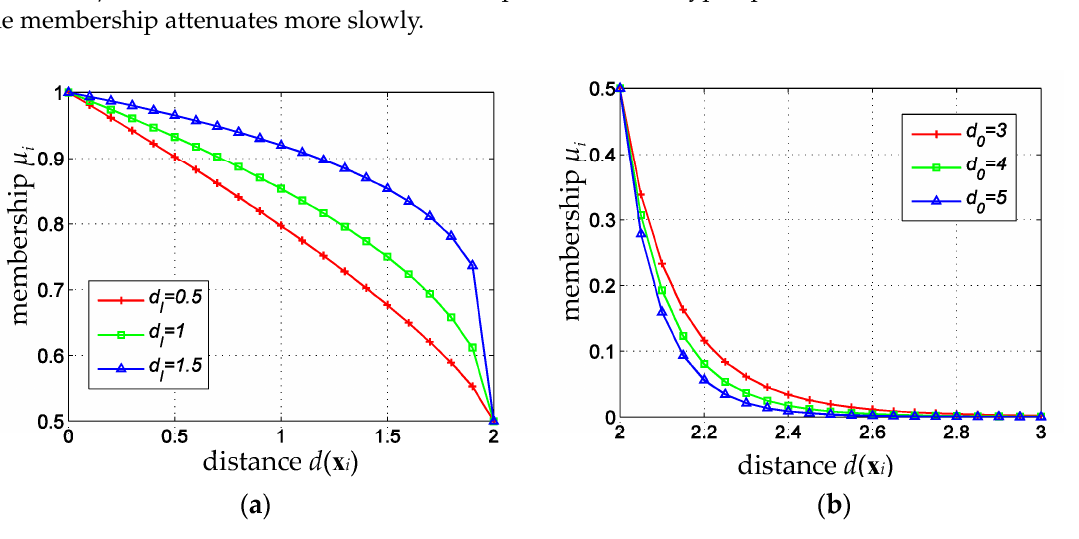
Figure 5. Membership curves corresponding to different d I and d o . ( a ) Membership curves to different d I ; ( b ) Membership curves to different d o